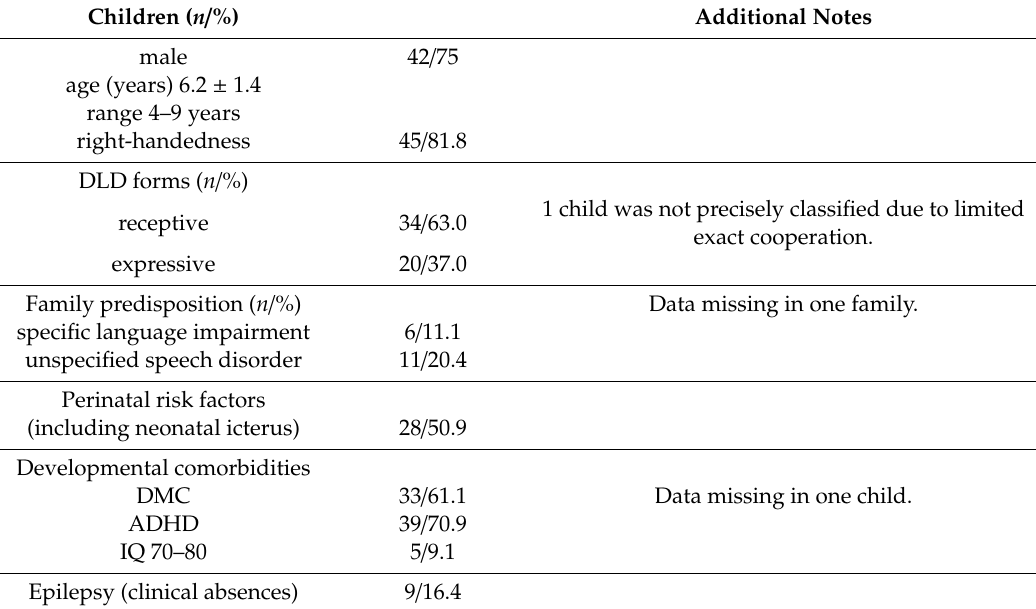
Table 1. Developmental language disorder (DLD) clinical data ( n =